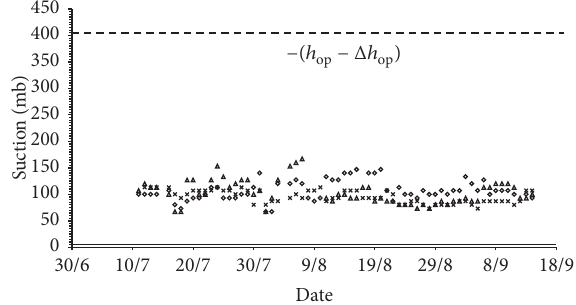
Figure 6: Temporal soil water content variation in the soil depth 𝑍 = 30 cm: at the inlet 𝑋 = 0 ( × ), at the behalf 𝑋 = 𝐿/2 ( 󳵻 ), and at the lateral end tip 𝑋 = 𝐿 (o)against ( 𝜃 dashed lines.